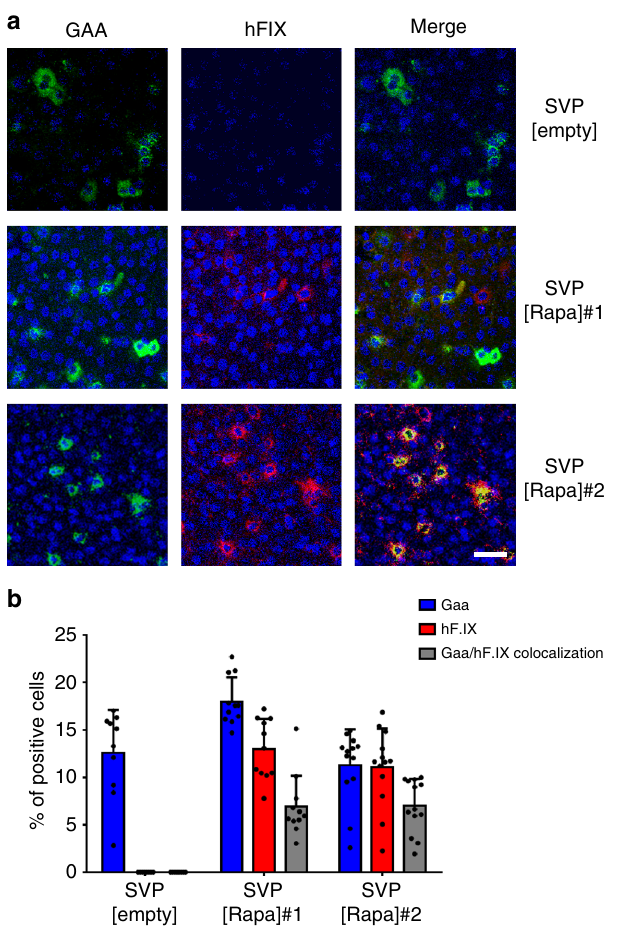
Fig. 3 Enhanced liver transduction via repeated AAV8 vector administrations in nonhuman primates. a Dual immuno fl uorescence staining of Gaa and hF.IX in livers from nonhuman primates treated with AAV8 vectors together with SVP[Rapa] ( n = 2, SVP[Rapa]#1 and SVP [Rapa]#2, 3 mg kg − 1 ) or SVP[empty] control ( n = 1). 95 days post AAV8- Gaa administration, liver lobes were collected and stained for Gaa (shown in green), hF.IX (shown in red) and Gaa/hF.IX co-localization (merge, shown in yellow) and nuclei are DAPI-stained (Blue). Scale bar 20 μ m. b Quanti fi cation of cells positive for Gaa, hF.IX and double-positives to Gaa/hF.IX in liver lobes. Data are shown as mean ± s.d. (four different images per lobe were analyzed for each